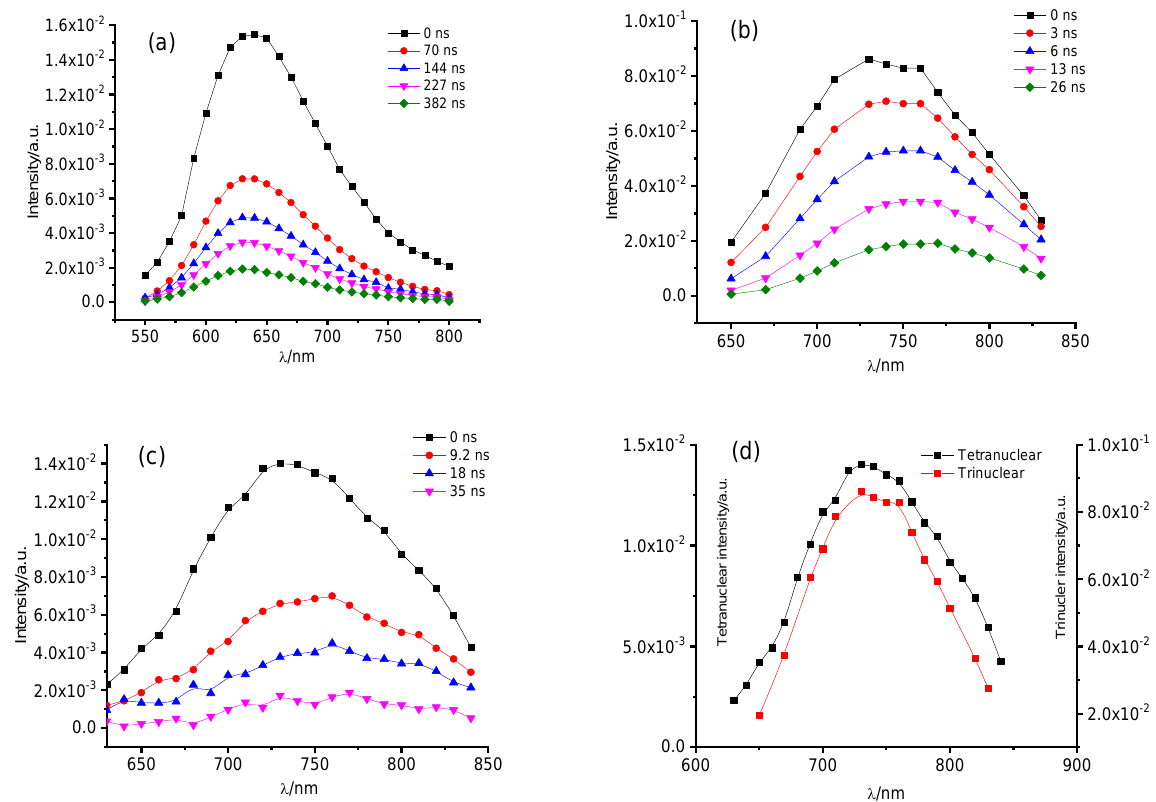
Figure 6. Time resolved emission profiles on ZrO 2 thin film: ( a ) 2 (Ru(TMAM)-Ag + ), ( b ) 3 (2907-Ag + ), ( c ) 4 (2Z907-Ag + - Ru(TMAM)), and ( d ) Comparison between emission spectra of complex 3 and of complex 4 at 0 delay. Thin films are in contact with 0.1 M Li + in ACN.